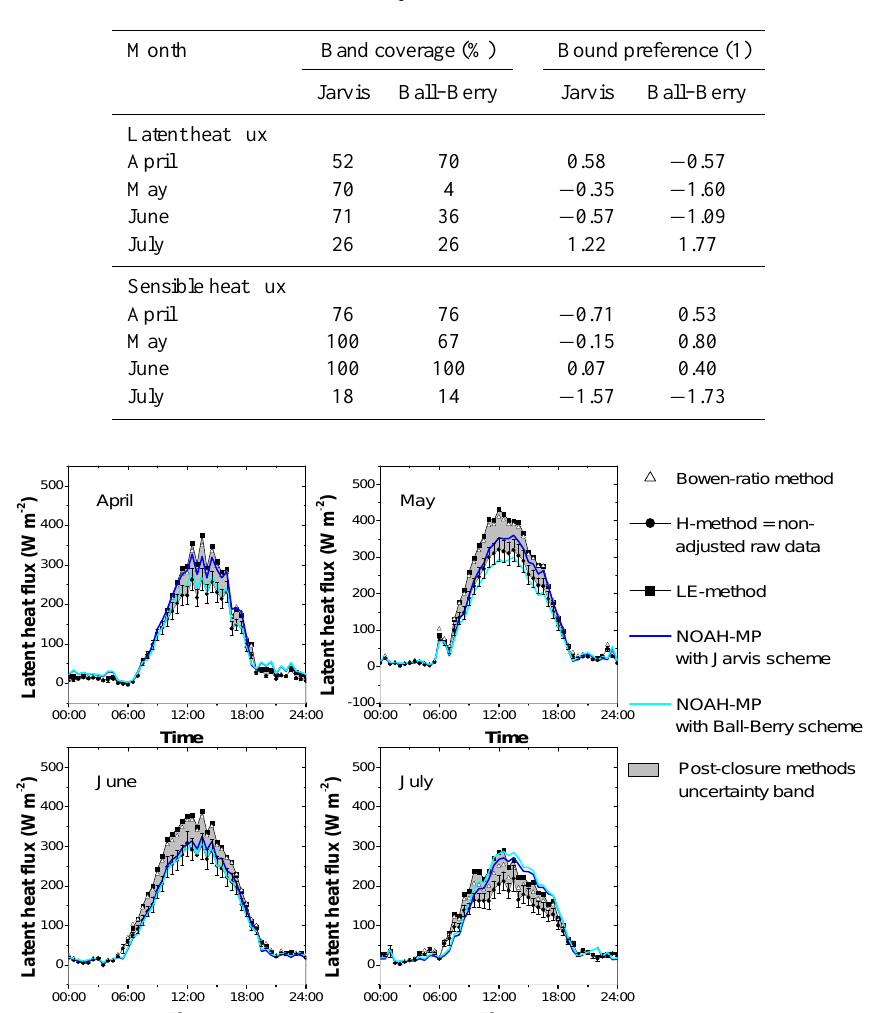
Table 5. Evaluation criteria of the post-closure methods uncertainty bands (PUBs) presented in Figs. 9 and 10. The PUB was computed from the difference between sensible heat ( H )- and latent heat (LE)-adjusted fluxes.